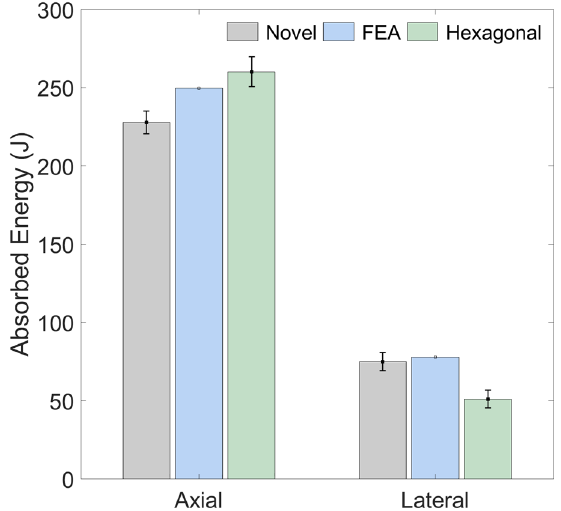
Figure 17. Comparison of energy absorption between the novel and hexagonal honeycomb (left) in the original scale. The blue column (FEA) represents the numerical results for the novel geometry, whereas the gray (novel geometry) and green (hexagonal geometry) columns represent the average experimental results for these forms.